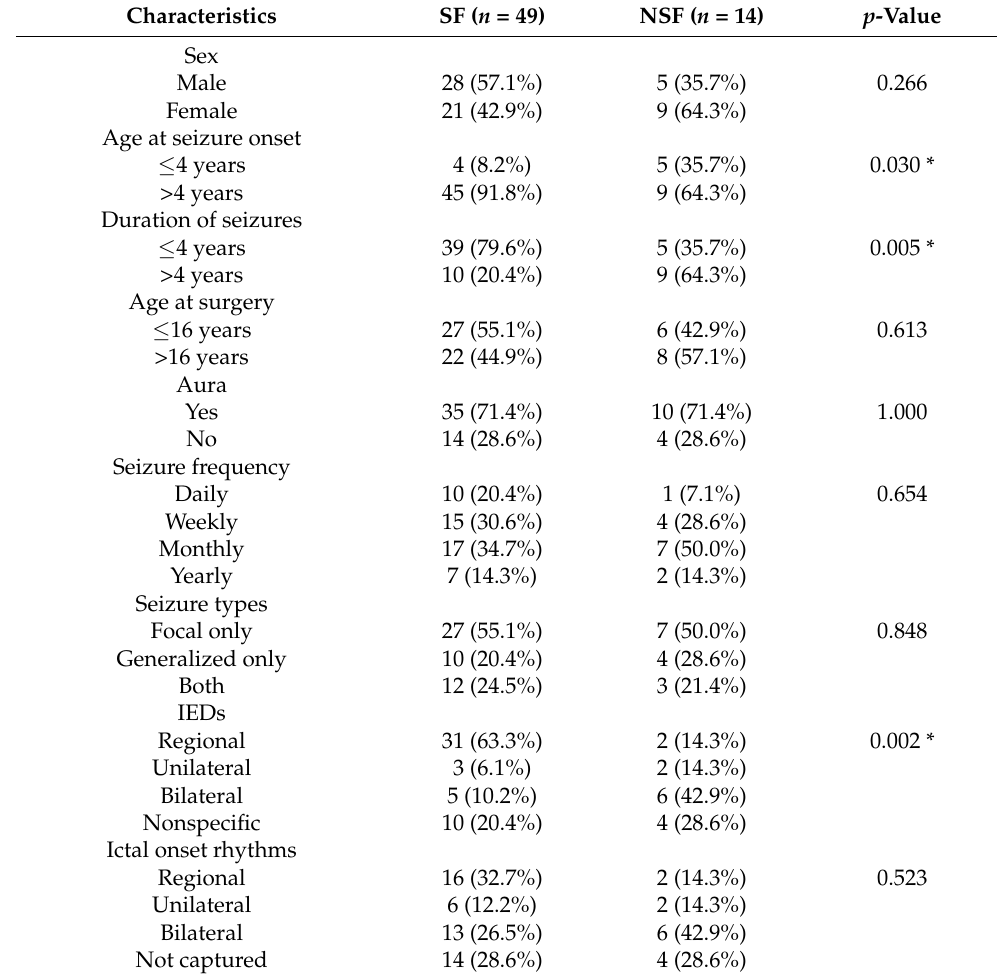
Table 1. Demographic and clinic characteristics of patients and the relationship with seizure